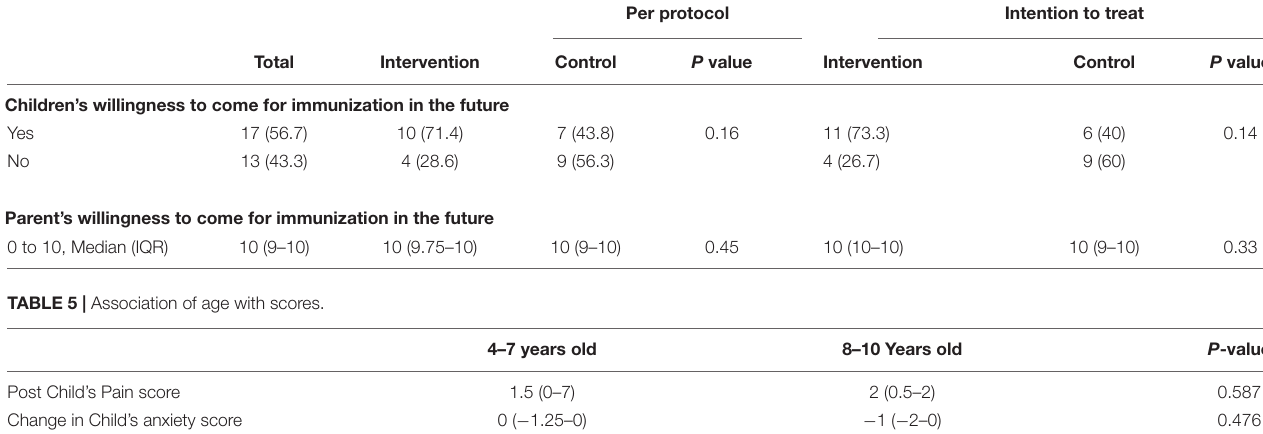
TABLE 4 | Children’s and parent’s willingness to proceed with future immunization.